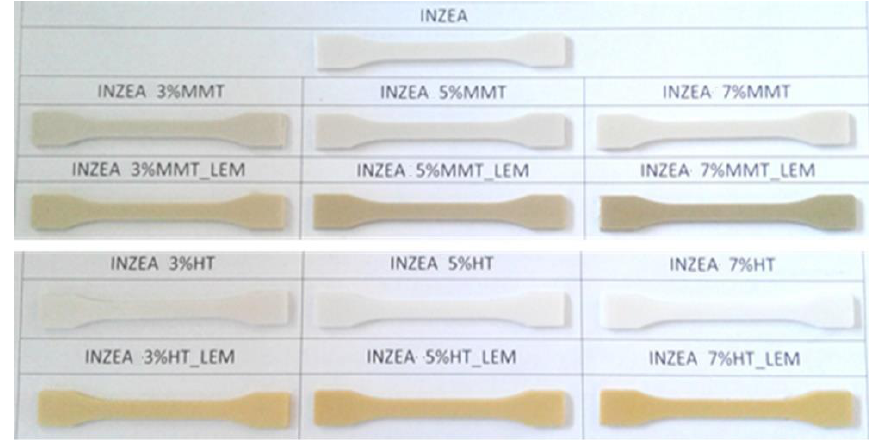
Figure 4. Polyester-based matrix (INZEA)-based bio-nanocomposites obtained at different lemon hybrid pigments loading (3, 5, and 7 wt%). Table 6. CIELAB parameters for INZEA bio-nanocomposites with MMT and HT lemon hybrid pigments (m ± SD; n = 3).